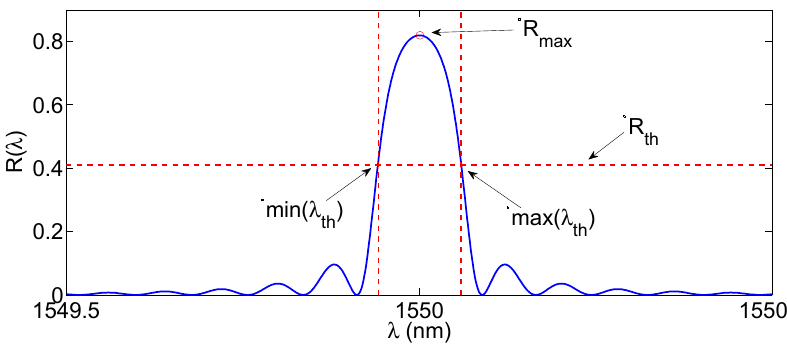
Figure 5. Sketch of the X-dB bandwidth peak-tracking method. The method is depicted for X = 3 dB.